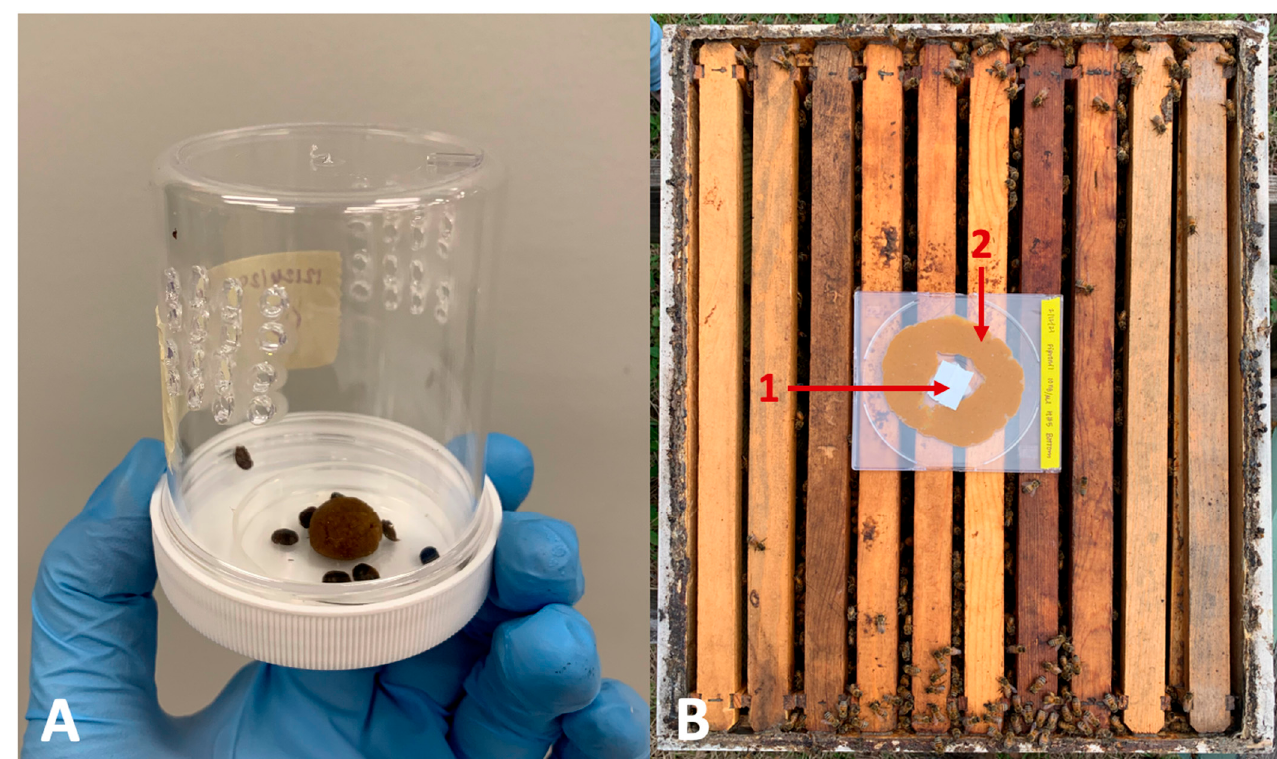
Figure 1. ( A ) Experimental cage design used for acute toxicity bioassays. Ten adult small hive beetles (SHBs) are placed in a ventilated cage with a 1 g ball of treated pollen. ( B ) Trap placed in the center of the hive between the lid and frames for the field trial. Traps were made from CD cases with three entrances to allow adult SHBs to access 25 g of treated pollen in the center (denoted by arrow 2). All other access to the pollen was prevented by covering small holes in the center of the CD case with tape (denoted by arrow 1).